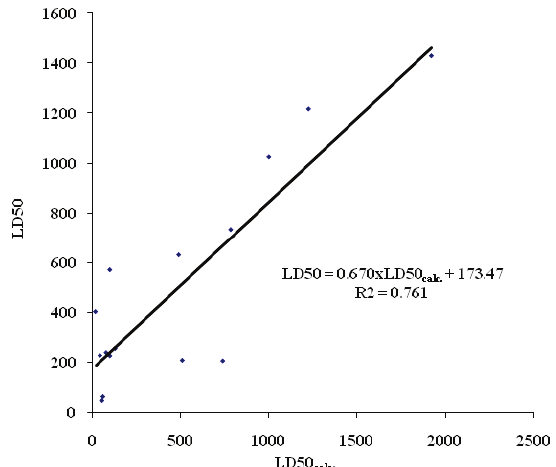
Figure 5. The plot of LD50 vs. LD50calc. for the test set (external validation).